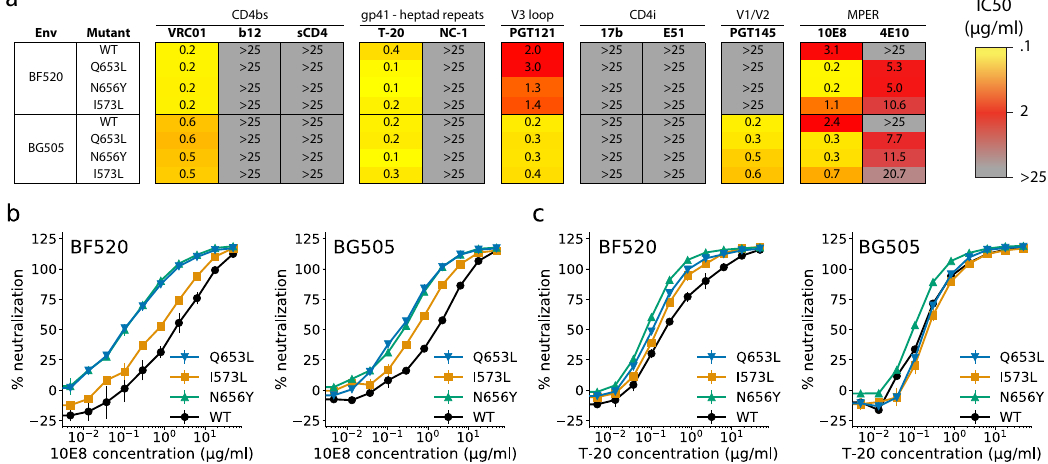
Figure 5. Neutralization of BF520 and BG505 point mutants. ( a ) IC50 values of the indicated drugs and mAbs with BF520 and BG505 Env point mutants. Values report the mean of two independent replicates and are representative of at least two distinct experiments. ( b , c ) Neutralization curves illustrating the e ff ects of Env point mutants on neutralization by 10E8 ( b ) and T-20 ( c ). Each data point indicates the mean of two independent replicates and error bars report standard